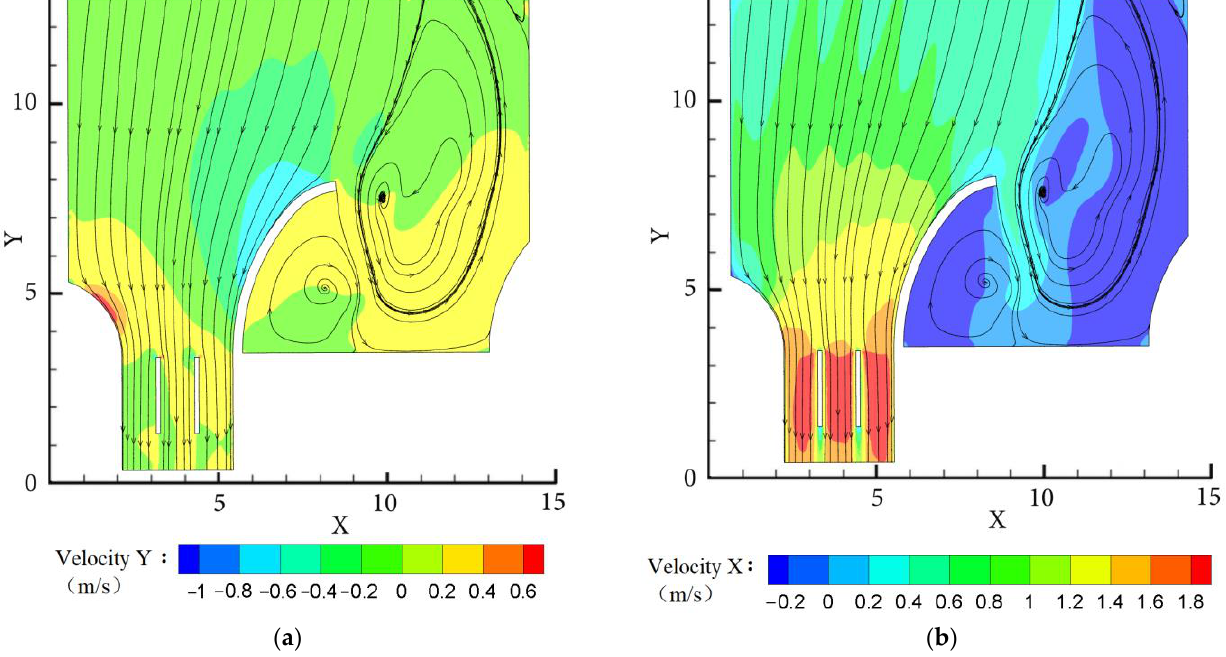
Figure 16. Flow field diagram of the surface and velocity cloud diagram under the free-draining condition: ( a ) transverse velocity cloud diagram, ( b ) axial velocity cloud diagram.